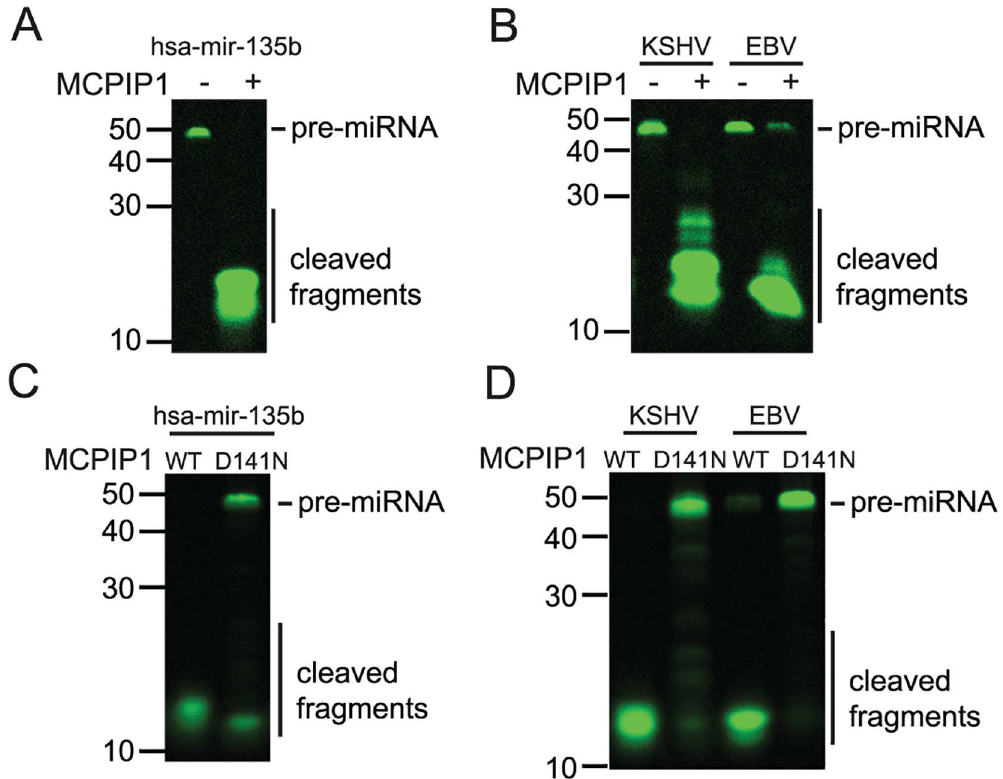
Fig 1. MCPIP1 directly cleaveshuman and viral pre-miRNAs. (A) In vitro cleavageassay for pre-hsa-mir-135b synthesized with 5’IRD800CWN labelsand incubatedwith or without recombinant MCPIP1. Samples were resolved on a denaturingurea gel and scannedusing an Odyssey scanner(LI-COR). Full-length pre-miRNAsand cleaved RNA products are indicated.(B) In vitro cleavageassay for pre-KSHV-mir-K12-3 and pre-EBV-mir-BART15 in the presenceor absence of MCPIP1. (C) In vitro cleavageassay for pre-hsa-mir-135bwith WT MCPIP1 or RNase dead, MCPIP1 D141N. (D) In vitro cleavageassays for pre-KSHV-mir-K12-3and pre-EBV-mir-BART15 with WT or MCPIP1 D141N.Three independentin vitro cleavageassays were performed, and a representative image is shown for each